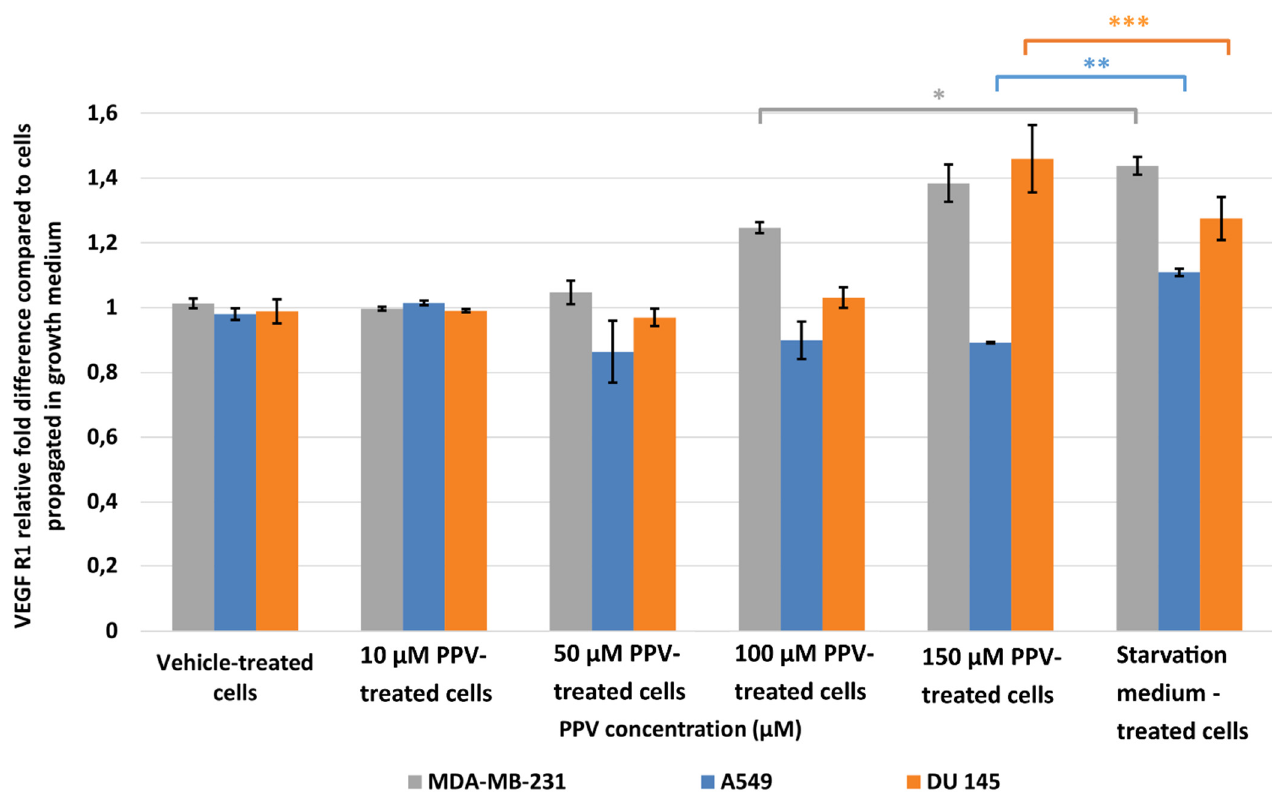
Figure 6. Spectrophotometry results of VEGF R1 ELISA demonstrating the effects of PPV (10–300 µ M) on proliferation on MDA-MB-231 cells compared to A549- and DU145 cell lines at 48 h. The average of three independent experiments is represented by the graph with error bars indicating standard deviation. The statistical significance of MDA-MB-231 cells is indicated with an asterisk (*), the statistical significance of A549 cells is indicated with two asterisks (**), and the statistical significance of DU145 cells is indicated with three asterisks (***). Statistical significance is represented by an * when using the student t -test with a P value of 0.05 compared to cells propagated in complete growth medium.